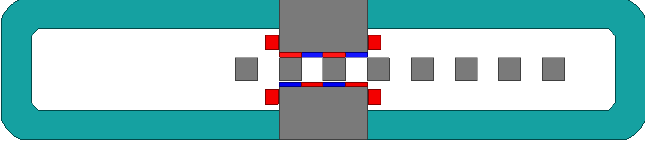
Figure 11. The model of equivalent 2D FEM of the unit machine of the conventional TTFFRLM.